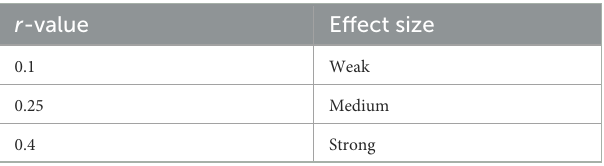
TABLE 2 Effect sizes of the Wilcoxon test according to Cohen